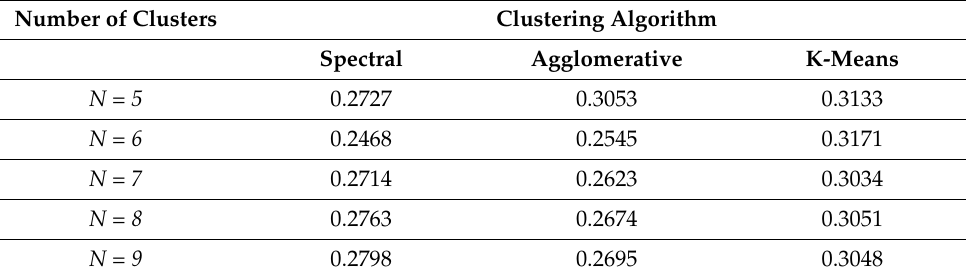
Table 5. Obtained silhouette coefficients for PCA-generated